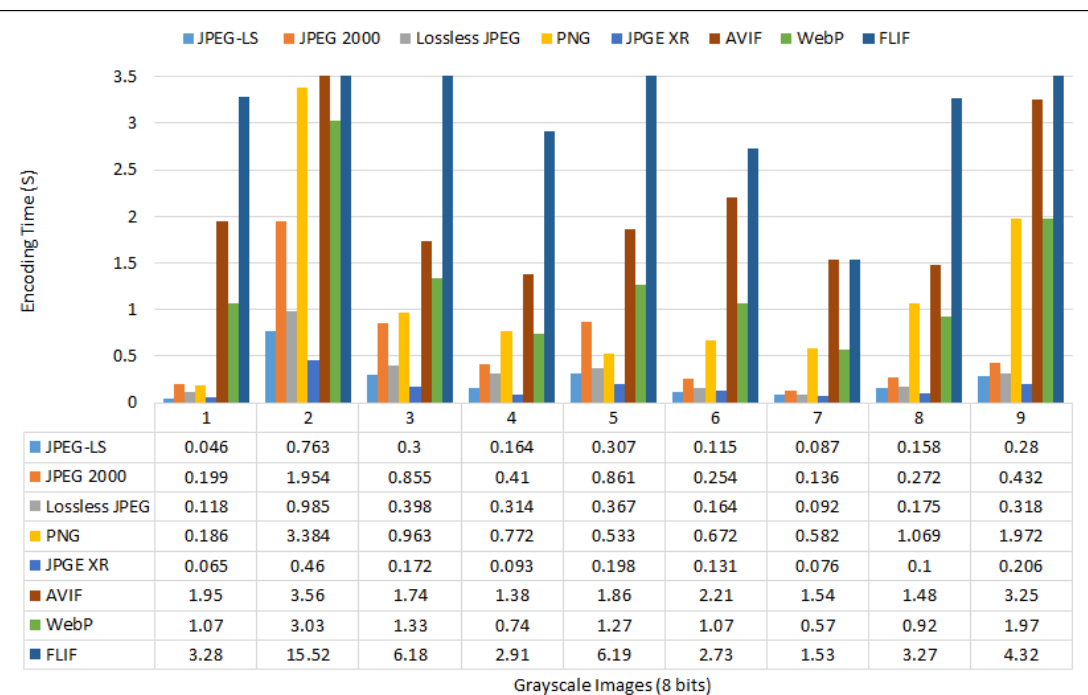
Figure 15. Encoding times for 8-bit greyscale